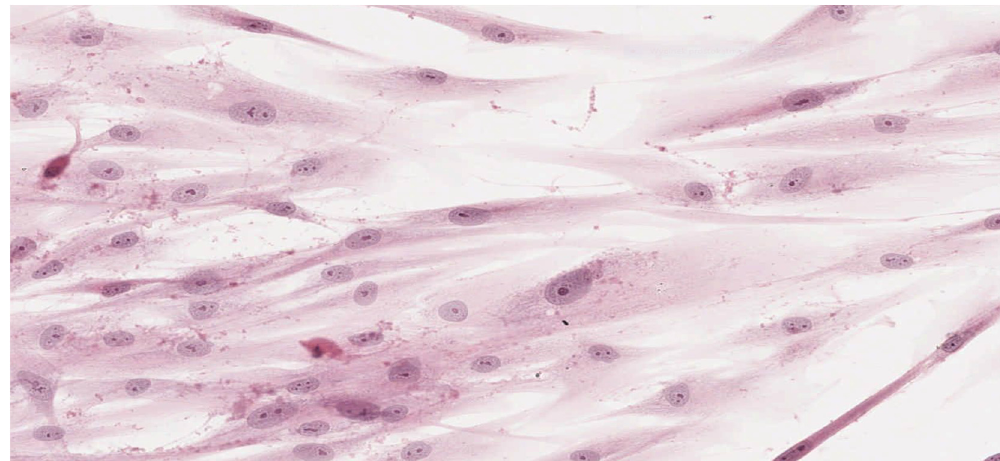
Figure 4. Image of cells cultured on medium with BLEND-A-DENT Plus; 200× magnification.